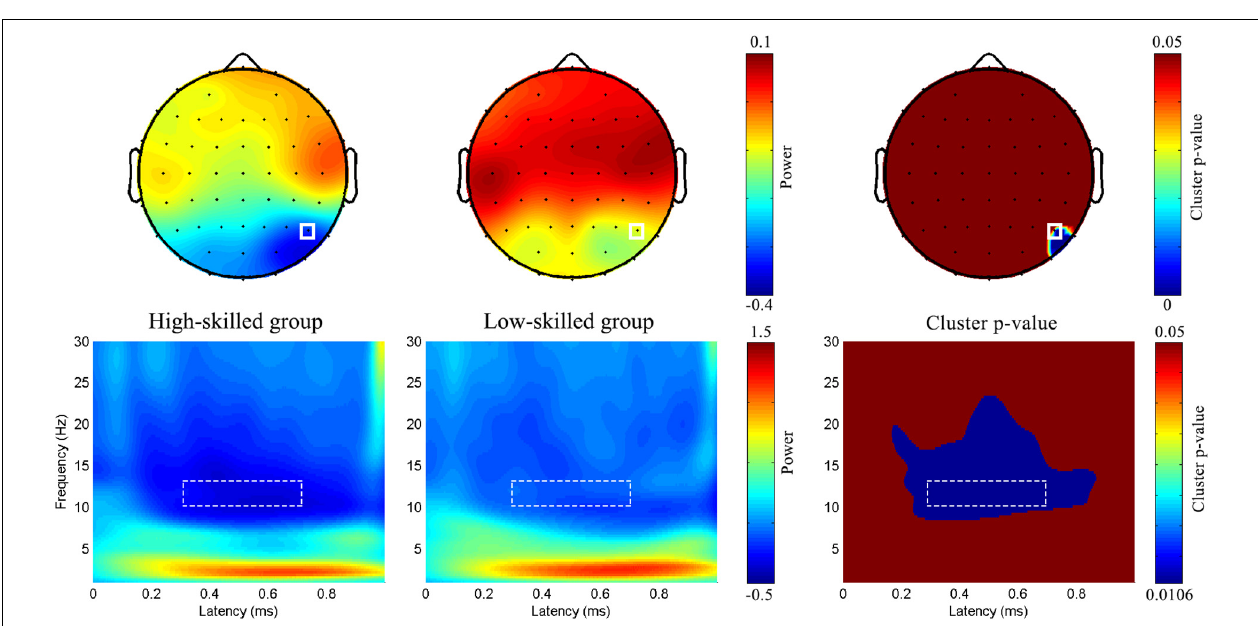
FIGURE 5 | Group-level topographic map and time-frequency features in the absolute discount. Topographic maps of the time-frequency ROI was displayed in the first half. And full rectangle represented P5 electrode. The bottom half was the time-frequency features of P5 electrode. Dotted rectangle represented the time-frequency ROI.